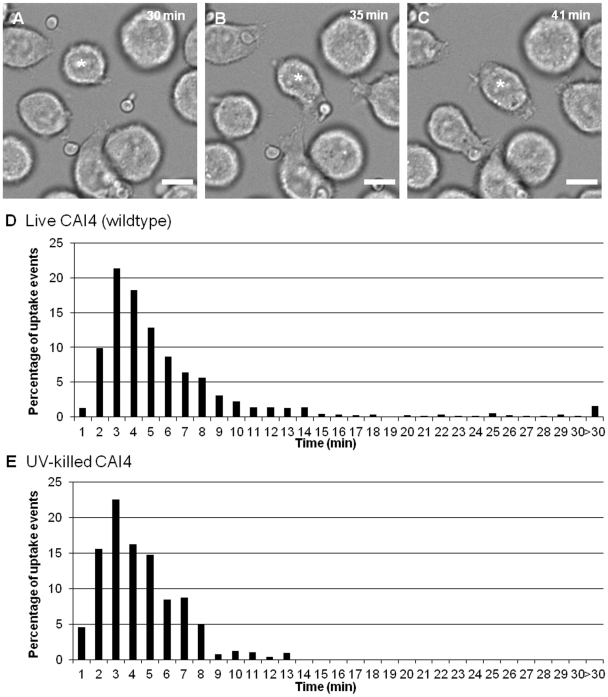
Macrophage engulfment of live and UV-killed wildtype C. albicans.
Figures 3A, B, and C are snapshots taken from live cell video microscopy capturing the engulfment process. Figure 3A shows a macrophage (*) and C. albicans prior to cell-cell contact, Figure 3B shows the same cells during contact and Figure 3C shows C. albicans within the macrophage post engulfment. Scale bar, 10 µm. Figures 3D and 3E show the time taken for J774.1 macrophages to ingest live and UV-killed wildtype C. albicans following cell-cell contact verses the percentage of uptake events, respectively (n = 6). The majority of live C. albicans were engulfed rapidly by macrophages once cell-cell contact was established (Figure 3D). However, UV-killed C. albicans were engulfed more swiftly, with all cells internalised within 15 min (Figure 3E).